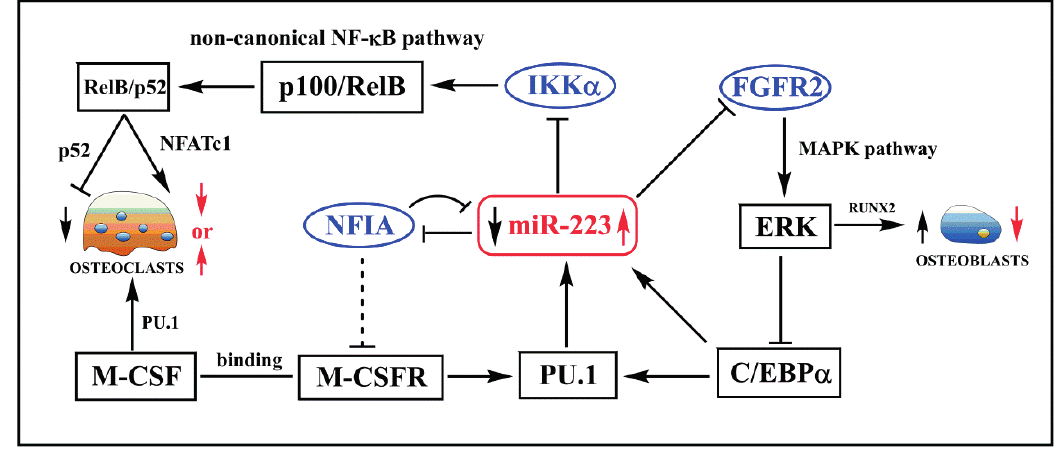
Figure 1. Schematic showing multiple regulatory networks of aberrant expression of miR-223 in regulating bone metabolism. MiR-223(shown as red) can regulate differentiation of osteoclasts and osteoblasts by repressing transcriptional factors, such as NFIA, IKK α and FGFR2 (shown as blue). Solid arrows indicate the promotion of cellular processes. Dotted lines indicate the mechanism has not been fully elucidated. Red short arrows indicate the regulation of overexpression miR-223, and black short arrows indicate the regulation of knockdown expression of